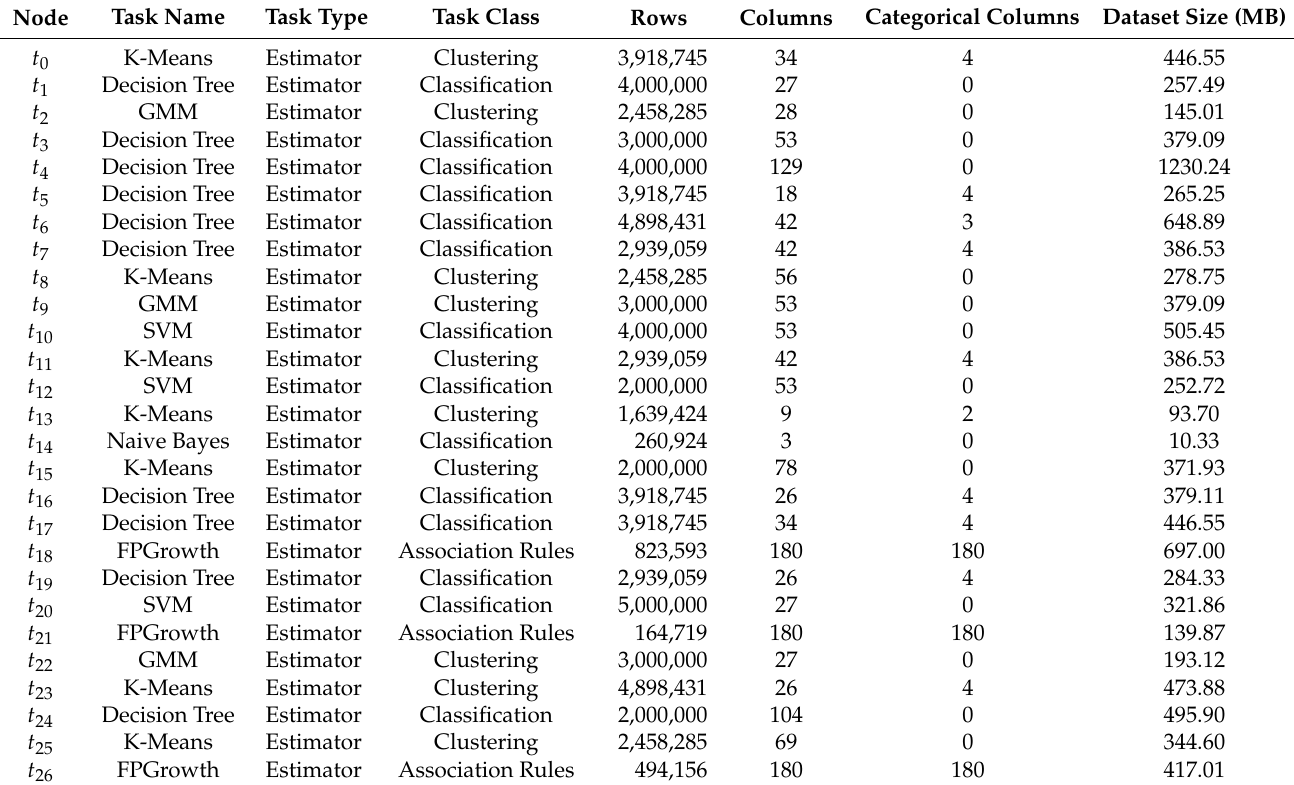
Figure 7. Task dependencies (Workflow 2). Table 10. Task and dataset descriptions (Workflow